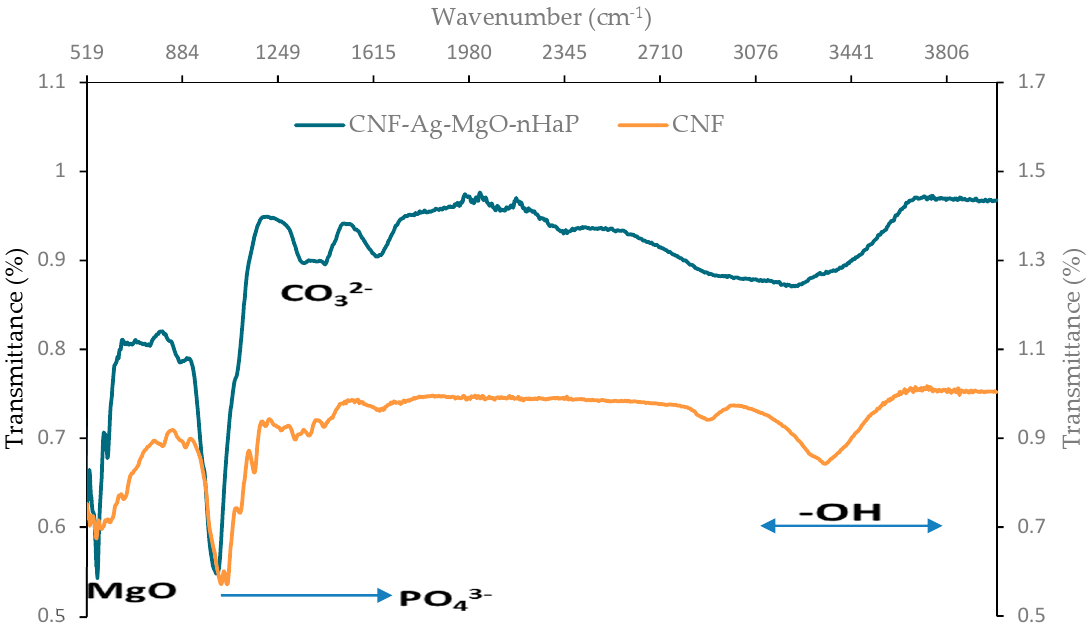
Figure 3. The FTIR spectra of CNF and CNF-AgMgOnHaP adsorbent.